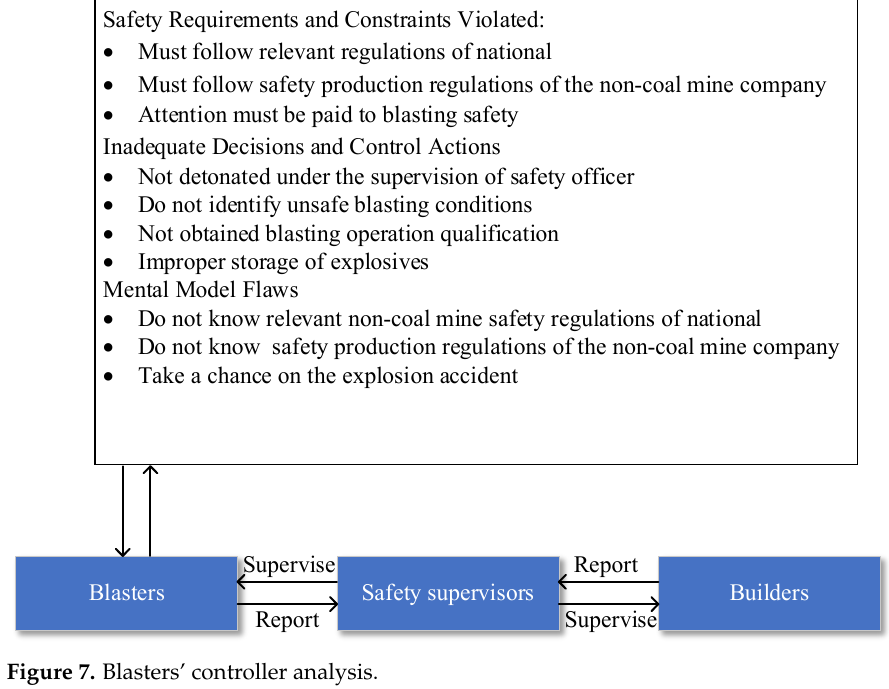
Figure 7. Blasters’ controller analysis.